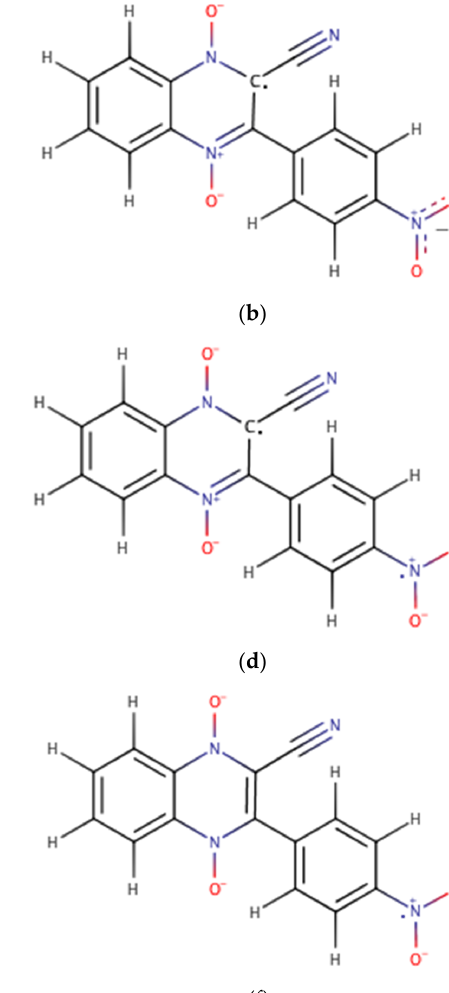
( d ) Figure 1. The individual structures for molecule A1: ( a ) the neutral molecule; ( b ) the possible anion product from Wave 1 with the radical on C2 ( c ) the possible anion product of Wave 1 with the radical on C3; and ( d ) the dianion product of Wave 2. Chemical structures drawn in MarvinSketch [20]. For the derivatives containing the nitro group (E1–E4), six (6) structures were created: the original neutral molecules, two (2) possible anion products from Wave 1, two (2) possible dianion products from the nitro group reduction (Nitro Wave), and the trianion product at the end of Wave 2. Figure 2 shows 2D structures created with MarvinSketch for each of the six (6) individual structures for molecule E1 [20]. The original neutral molecule is shown in Figure 2a. The two (2) possible structures for the product of Wave 1 have the radical assigned either to the C2, the carbon adjacent